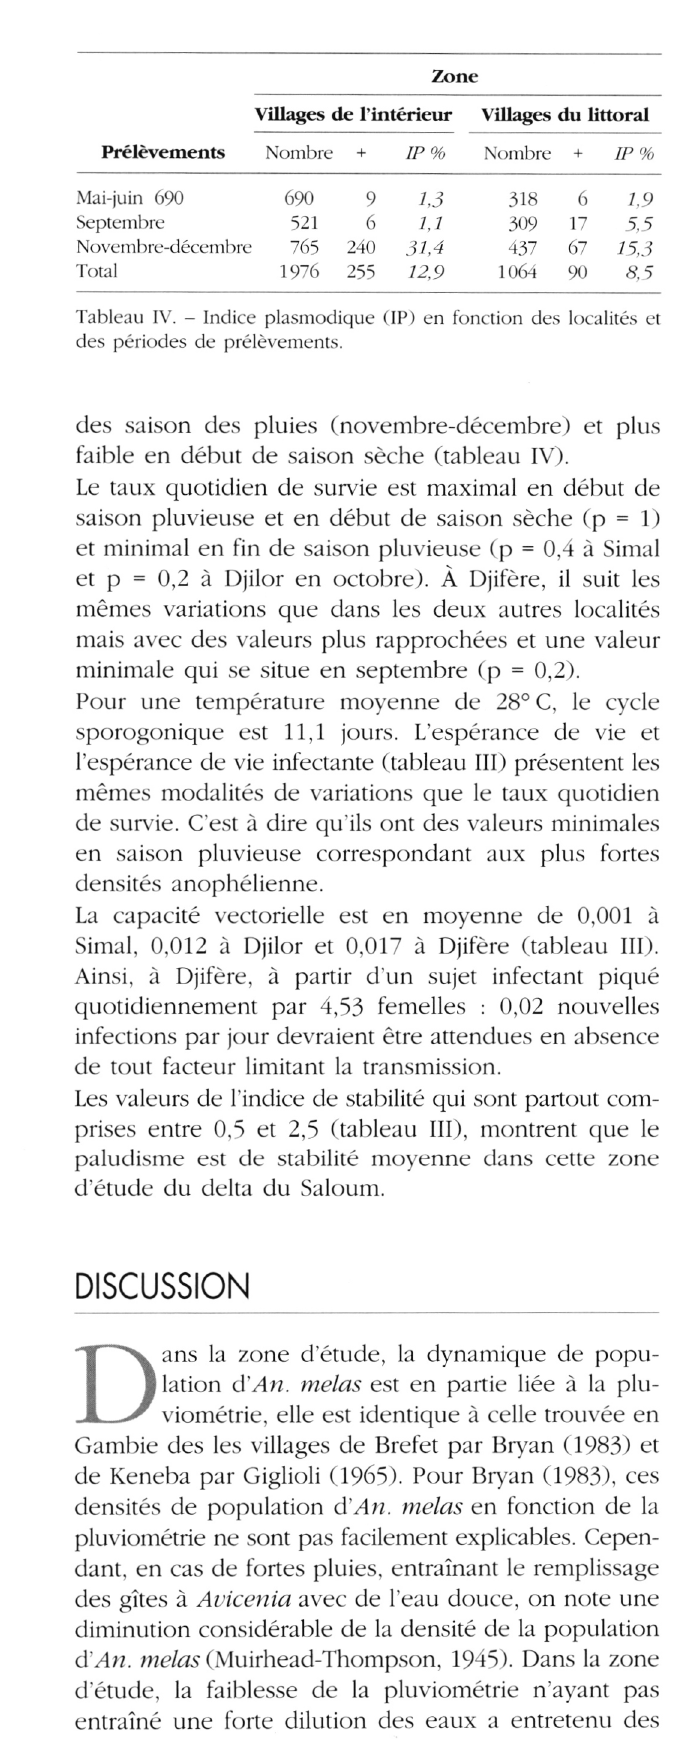
Tableau IV. - Indice plasmodique (IP) en fonction des localités et des périodes de prélèvements.